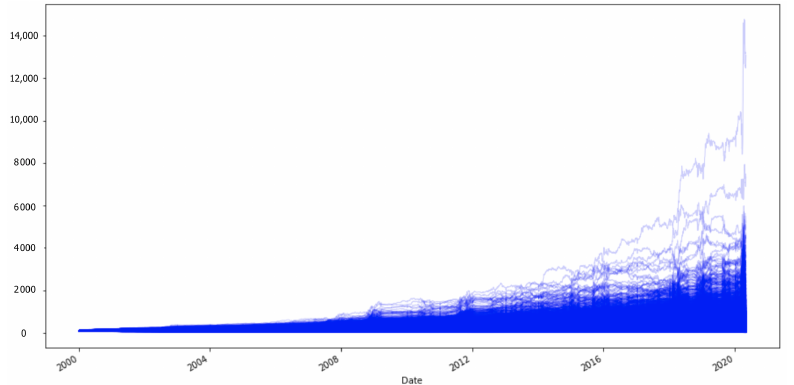
Figure 15. The picture graphically represents the results we obtained via Monte Carlo simulations over a 20 years horizon for the portfolio with historical volatility (source: authors’